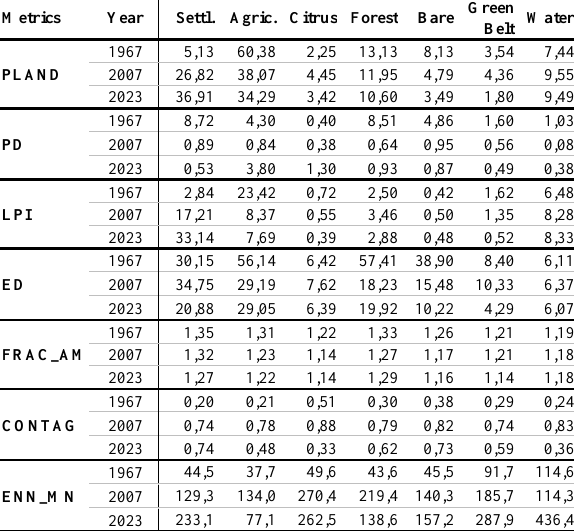
Table 3. Landscape metric result of 1996, 2007 and 2023 Metrics